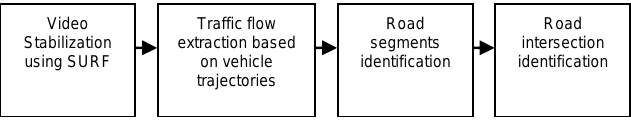
Figure ２ : Road Information Extraction Overview